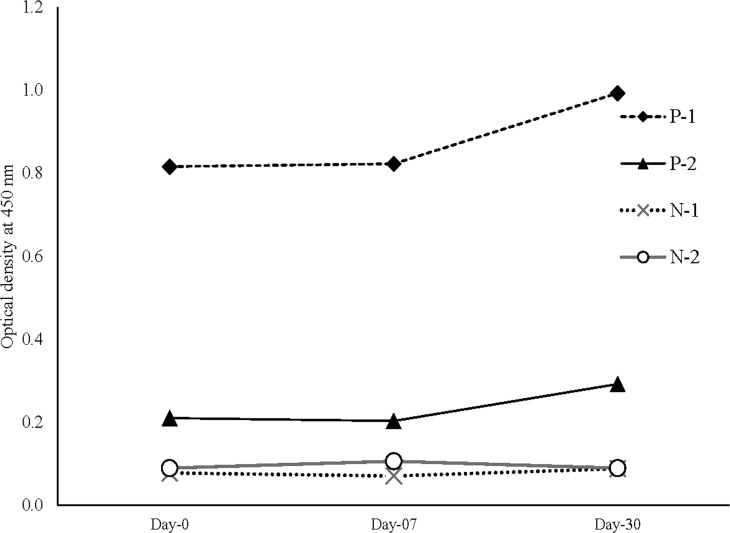
Stability profile of the coated plates tested with positive and negative controls.The coefficient of variance of the positive (P) and negative (N) controls showed in the acceptable ranges, which is 11.4, 21.1, 11.1 and 10.0 respectively for the P1, P2, N1 and N2, respectively.